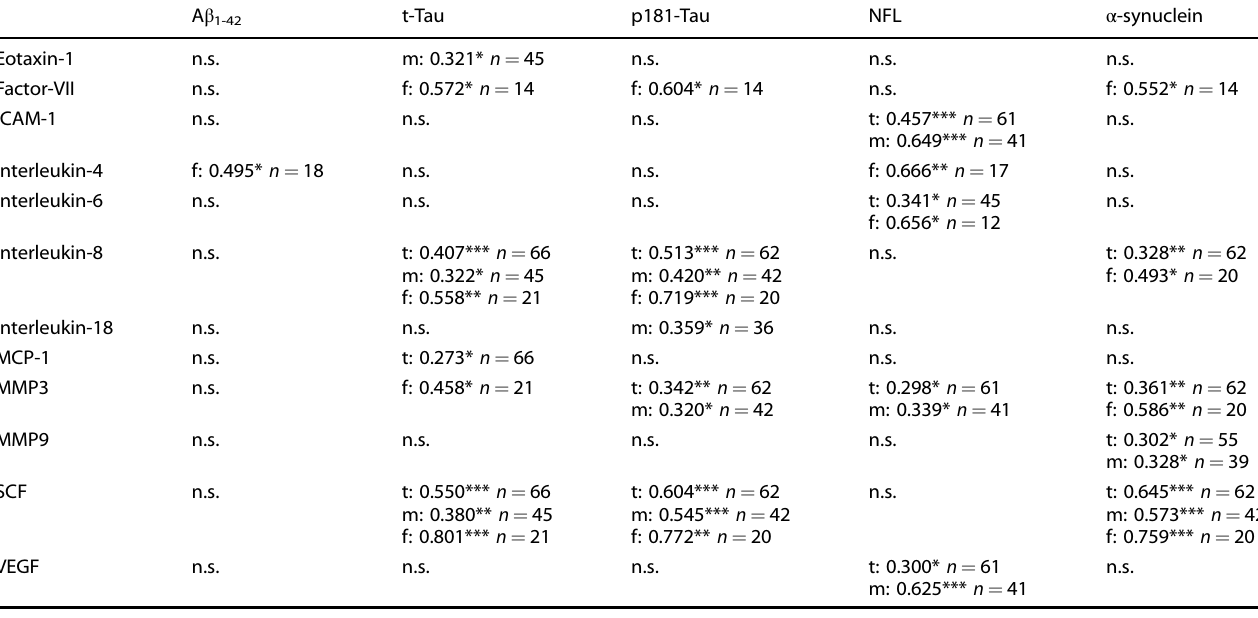
Table 4. Correlation between CSF in fl ammatory markers with CSF PD-biomarkers in people with dementia with Lewy bodies. A β